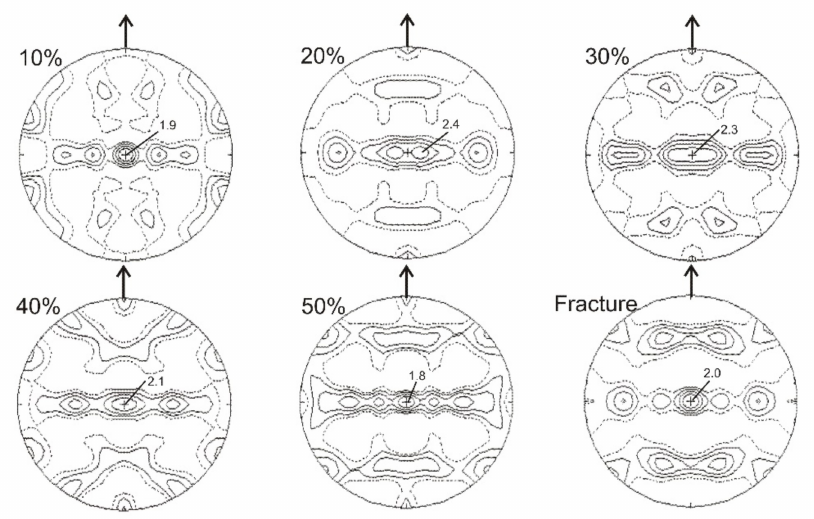
Figure 8. Calculated pole figure for ε -martensite {1120} after selected deformation